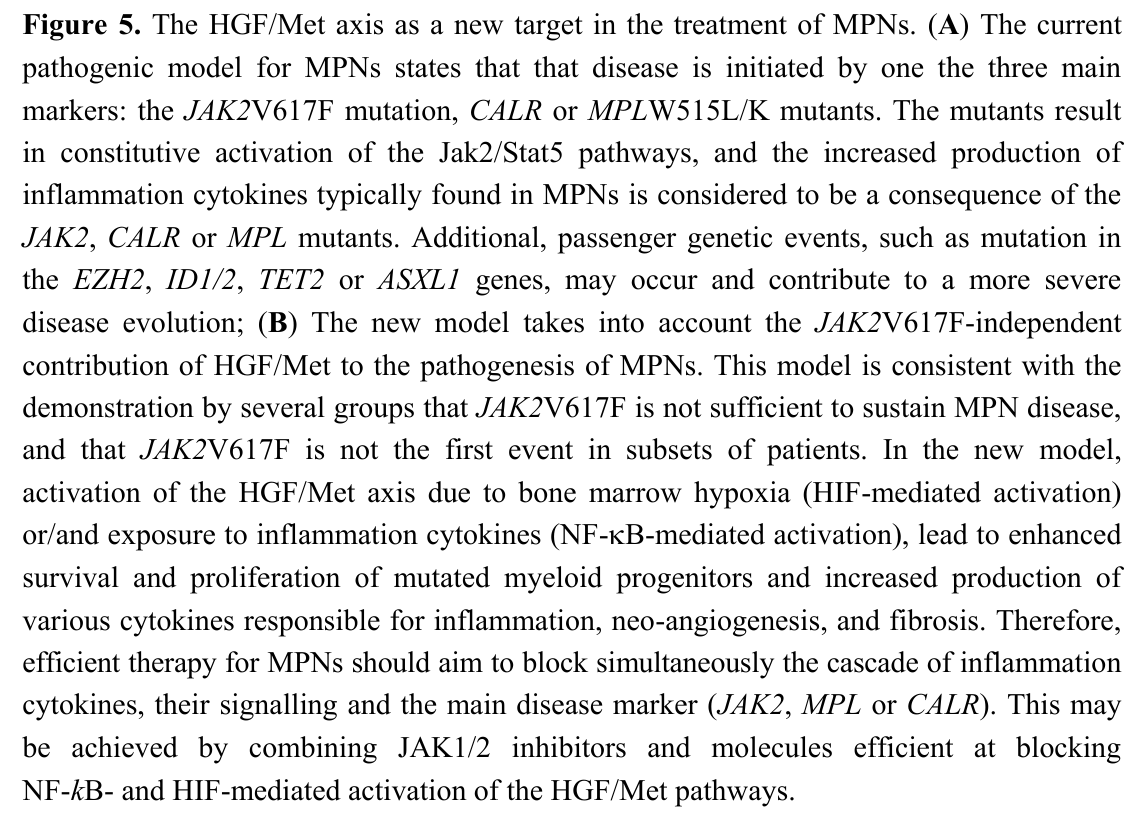
Figure 5. The HGF/Met axis as a new target in the treatment of MPNs. ( A ) The current pathogenic model for MPNs states that that disease is initiated by one the three main markers: the JAK2 V617F mutation, CALR or MPL W515L/K mutants. The mutants